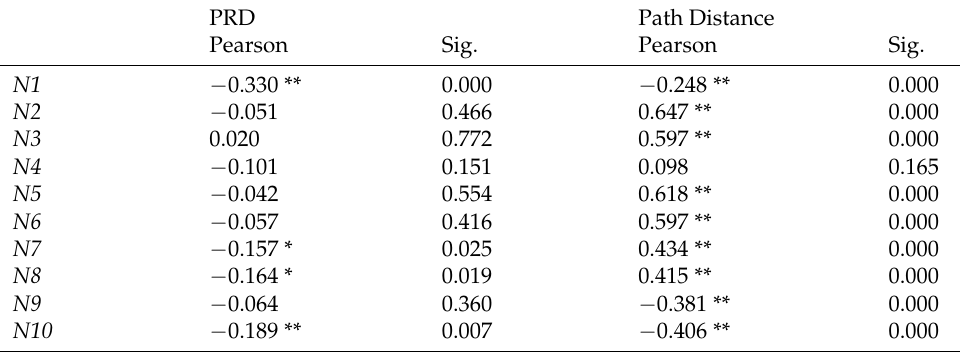
Table 9. Pearson correlation analysis. PRD Path